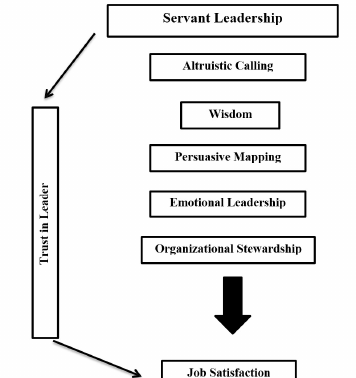
Fig. 3. Hypothesized servant leadership and its components, job satisfaction and trust in leader relationship Nanus (1989) implied that the basis for legitimacy of leaders is trust and it is trust that binds leader to follower. However, there is strong evidence that building trust in follower holds a greater importance than building trust in leader (Lee et al., 2010). Despite this finding, all previous researches have indicated a strong, clear connection between trust in leader and job